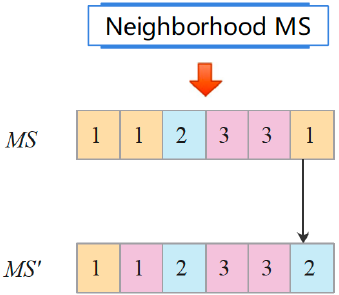
Figure 8. Example of machine